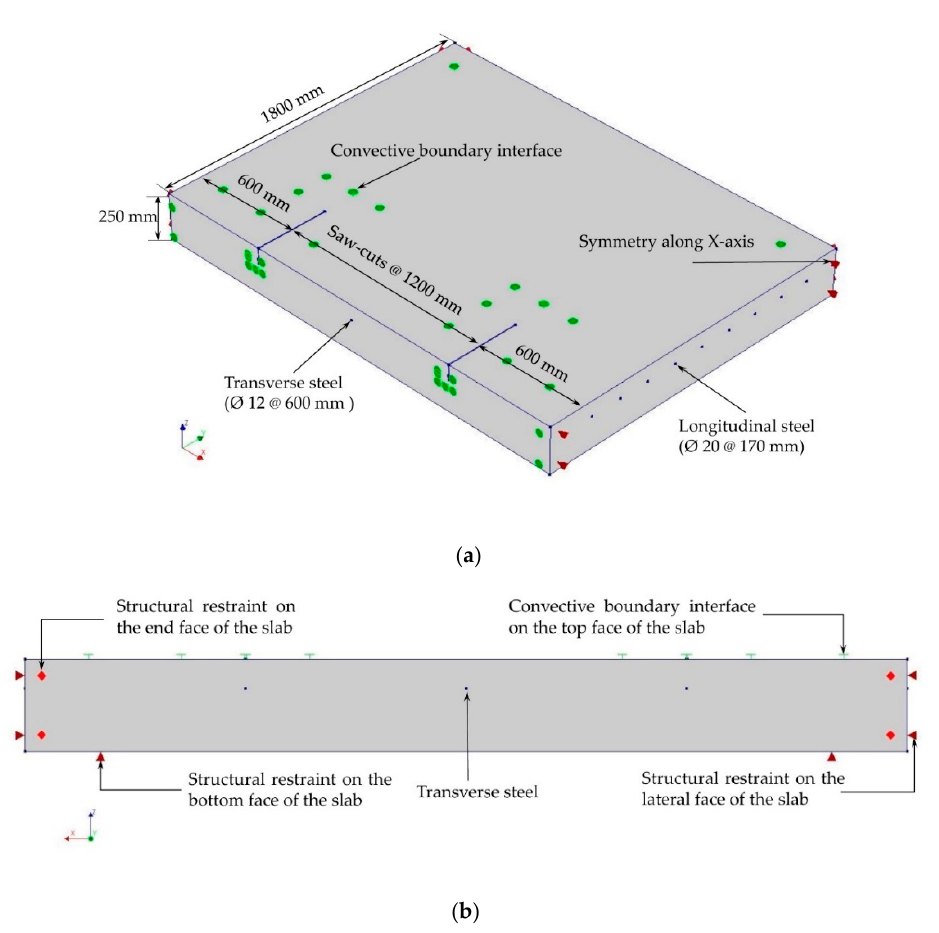
Figure 9. Boundary conditions of the FE model: ( a ) thermal boundary and ( b ) structural boundary.